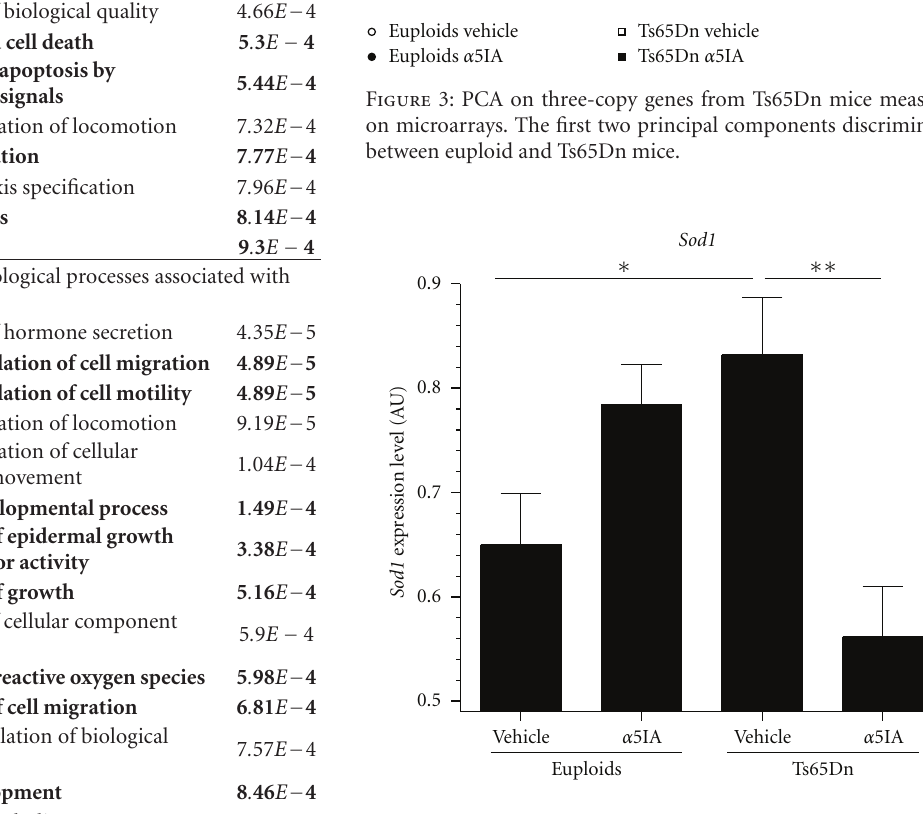
Figure 4: QPCR expression level of Sod1 gene in euploid and Ts65Dn mice after chronic treatment with vehicle or α 5IA. ∗ P < . 05, ∗∗ P < . 01, and two-way ANOVA with Fisher’s post hoc